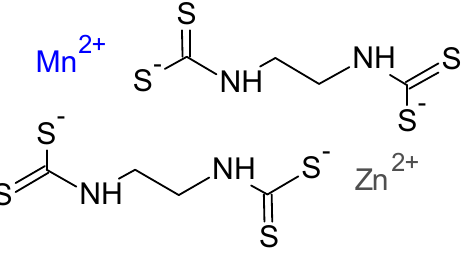
Figure 1. Chemical structure of mancozeb. Modified from [5].